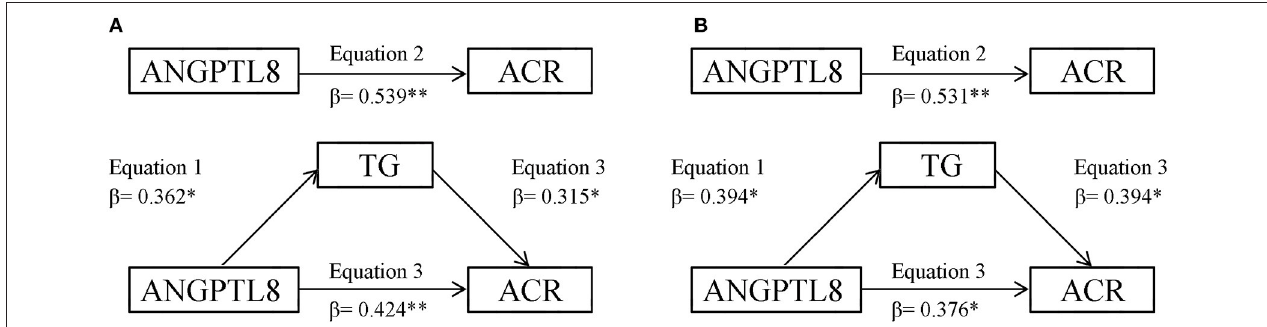
FIGURE 1 | (A) TG mediation models of the relationship between ANGPTL8 and ACR in type 2 diabetic patients with A2 group. (B) TG mediation models of the relationship between ANGPTL8 and ACR in type 2 diabetic patients with A3 group. * P < 0.05, ** P < 0.01.